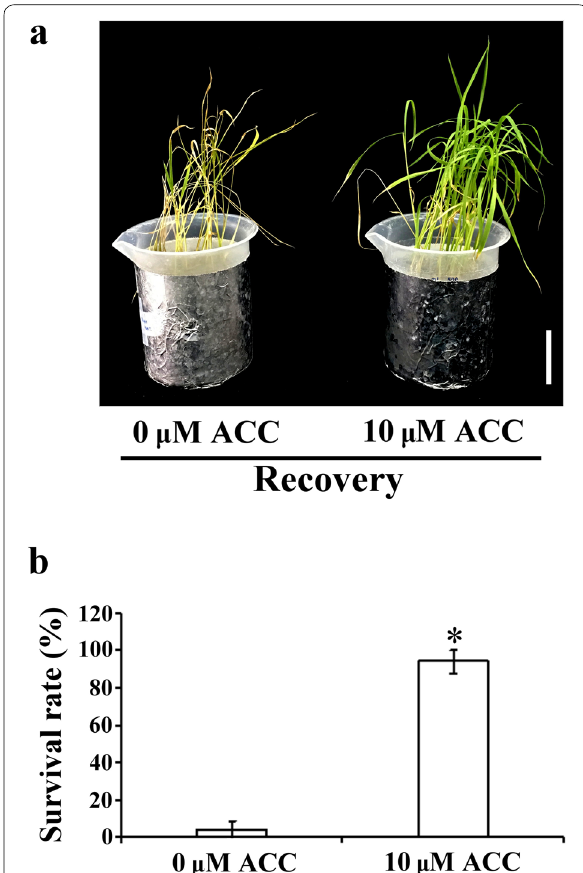
Fig. 2 Tolerance determination of rice seedlings under heat stress combined with ACC treatment. a Phenotypes of 12‑day‑old TK9 rice seedlings exposed to 45 °C heat treatment with or without 10 μM ACC for 4 days followed by recovery for 7 days. The same results were observed for three independent experiments. Bar Survival rate was determined after each treatment and recovery for 7 days. Bar 5 cm. The values are presented as mean = deviation based on 30 seedlings of each treatment obtained from six biologically independent experiments. * P < 0.05 versus value at 0 μM